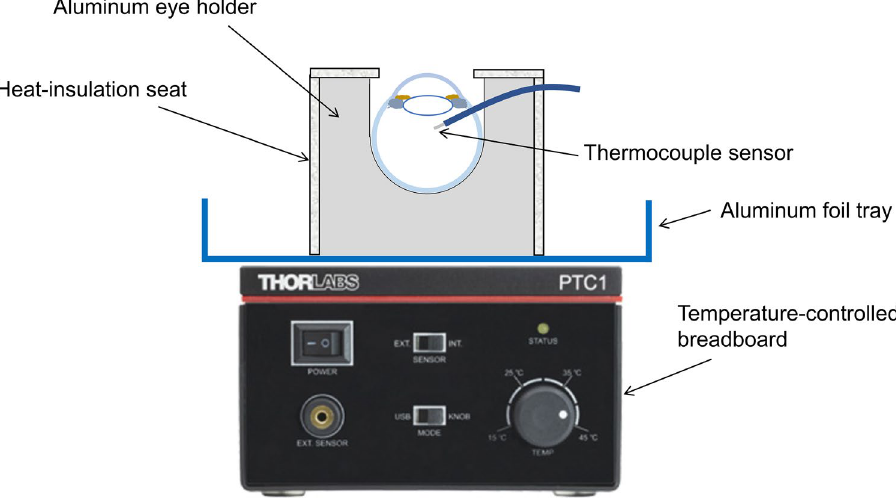
Figure 2. Schematic representation of the temperature-controlled eye